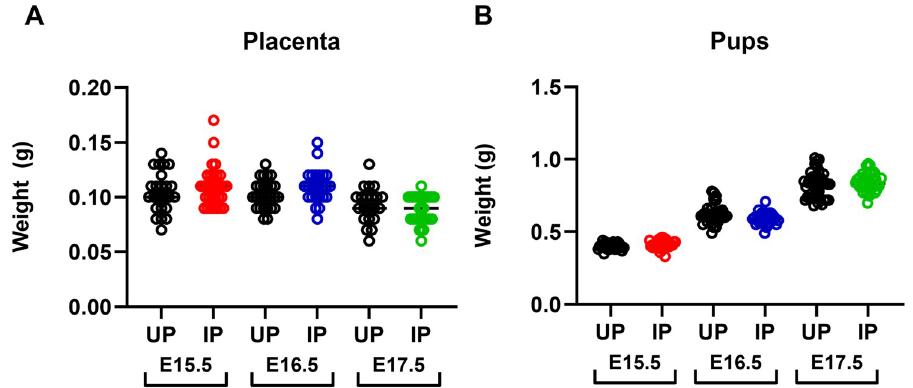
Fig 3. P . chabaudi AS infection does not significantly impact placenta or pup weight prior to preterm delivery. (A) Placenta and (B) pup weights depicted for uninfected pregnant (UP) and infected pregnant (IP) mice sacrificed one day before preterm delivery. These data are shown for visualization only; statistical analysis is in the text. E15.5 group: 4 IP dams, 32 placentae; 4 UP dams, 30 placentae. E16.5 group: 4 IP dams, 31 placentae; 4 UP dams, 33 placentae. E17.5 group: 5 IP dams, 40 placentae; 5 UP dams, 41 placentae.